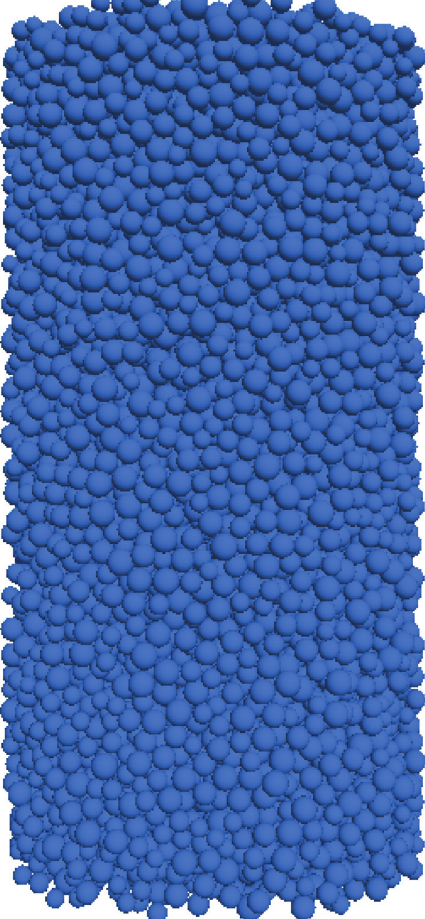
Figure 7: Initial model of coal sample PFC3D.